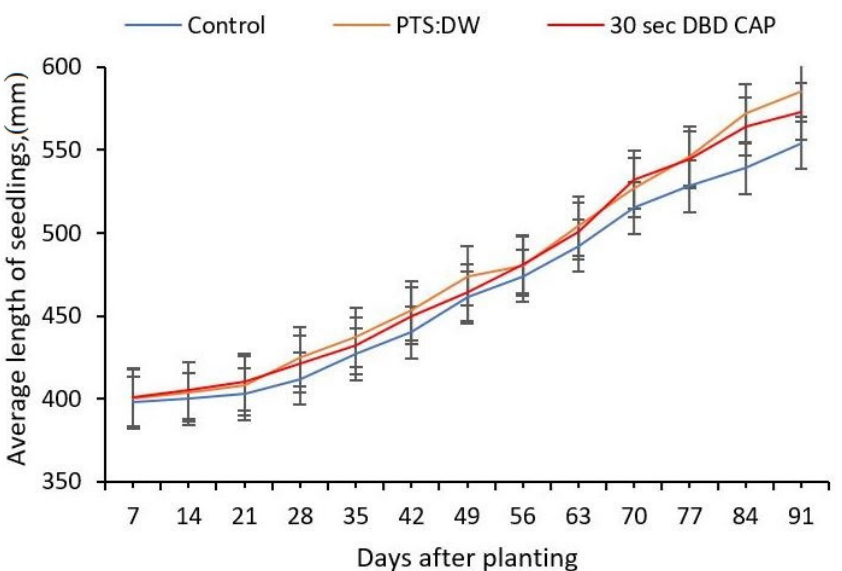
Figure 7. The average length of the grafted young pear trees after planting in the greenhouse.